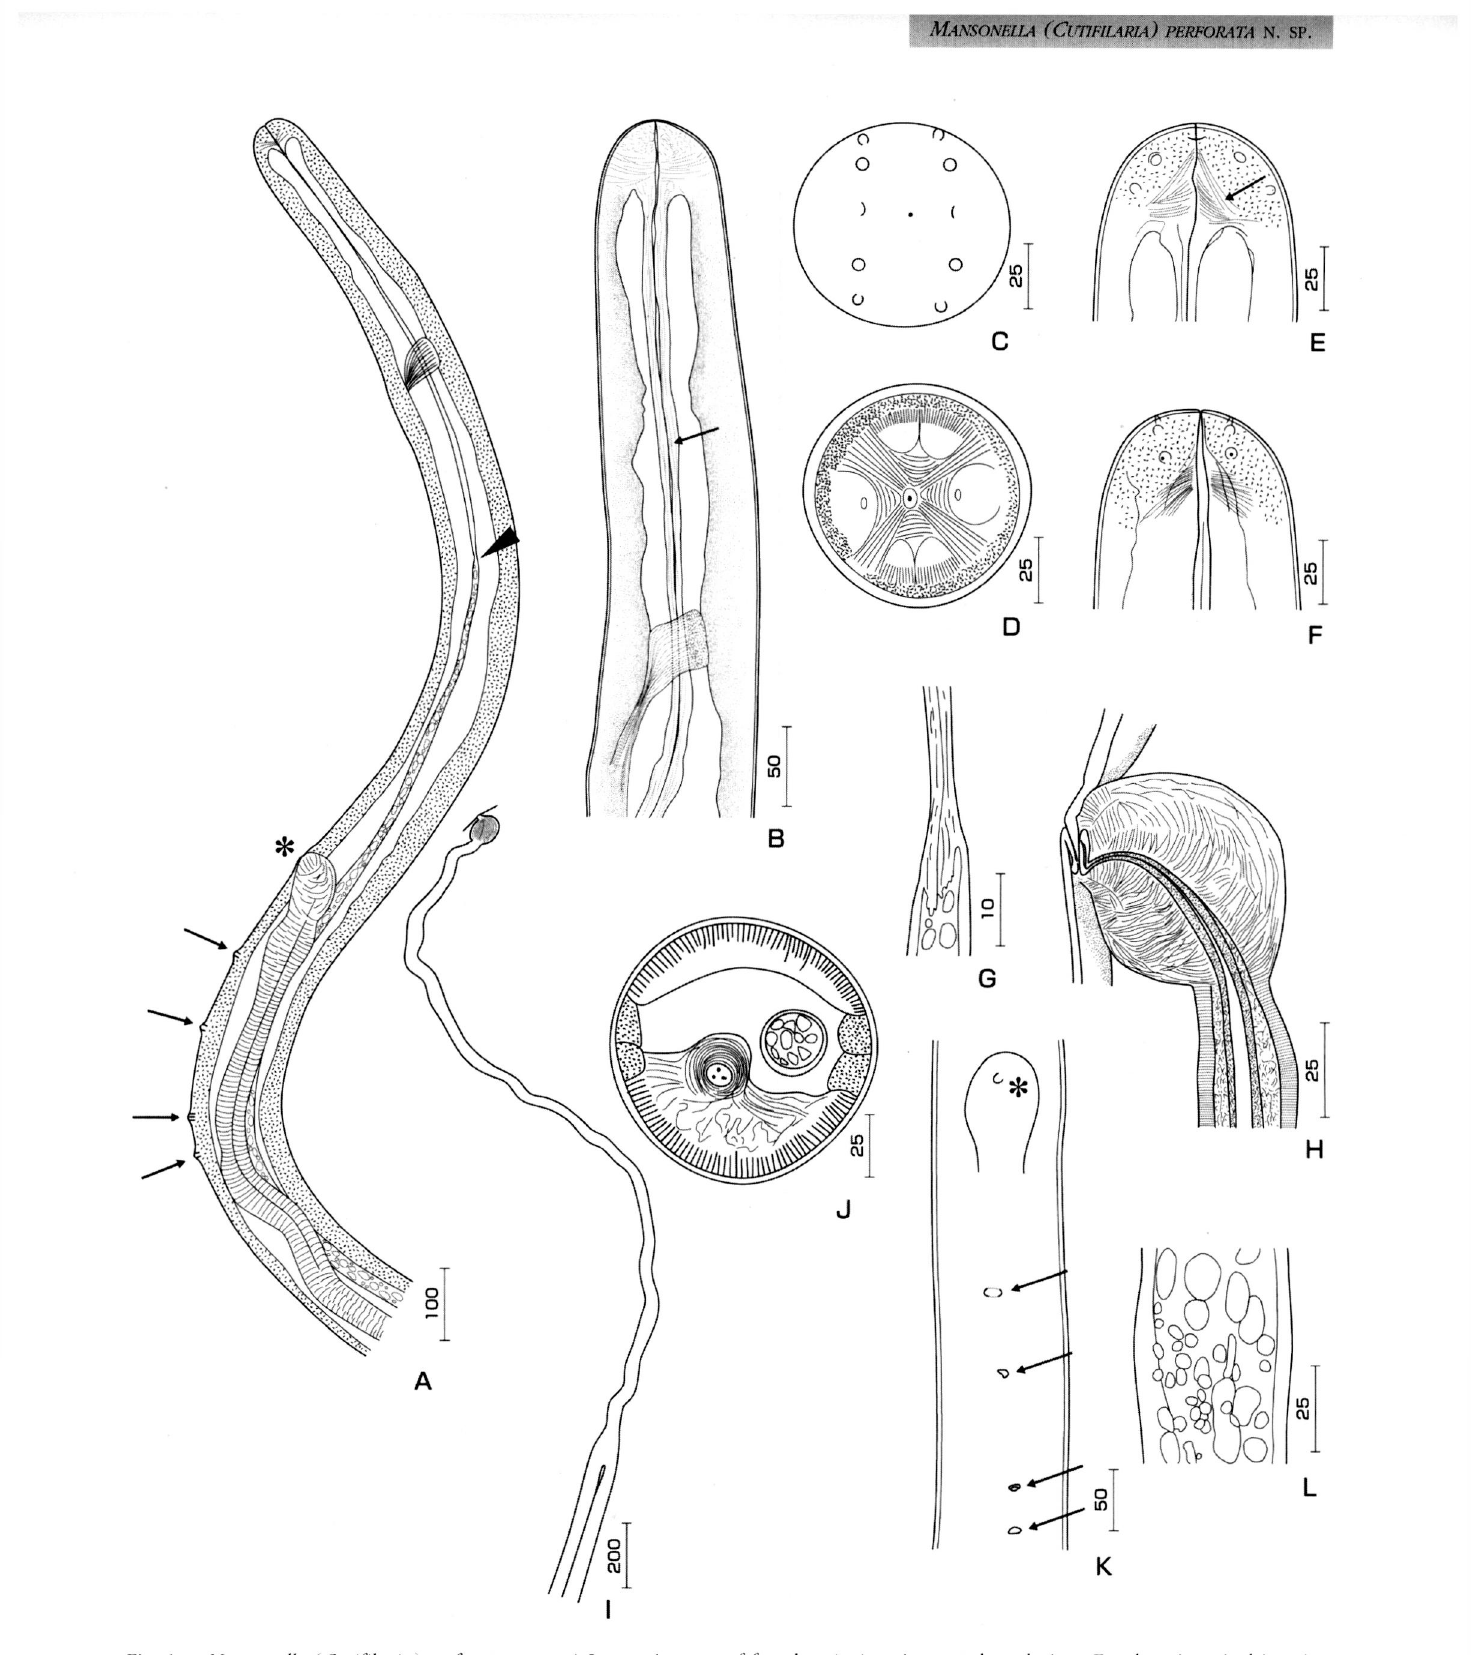
Fig. 1. - Mansonella (Cutifilaria) perforata n. sp. A-L, anterior part of females. A. Anterior part, lateral view. Esophagointestinal junction (arrowhead), vulva (*). and articular pores (arrows). 15. Enlarged anterior part, lateral view. Fibrous thread-like esophagus (arrow). C. Head, en face view. D. Transverse section of head, anterior part of digestive tract fused with the surrounding body muscles. E. Head, lateral view. Body muscles (arrow). F. Head, median view. G. Esophagointestinal junction. H. Vagina with the initial cuticular part of vulva. I. Ove- jector. J. Transverse section at the level of the vagina. K. Vulva (*) and cuticular pores (arrows), ventral view. L. Intestine. The thick wall contains granules. Bars, micrometers.